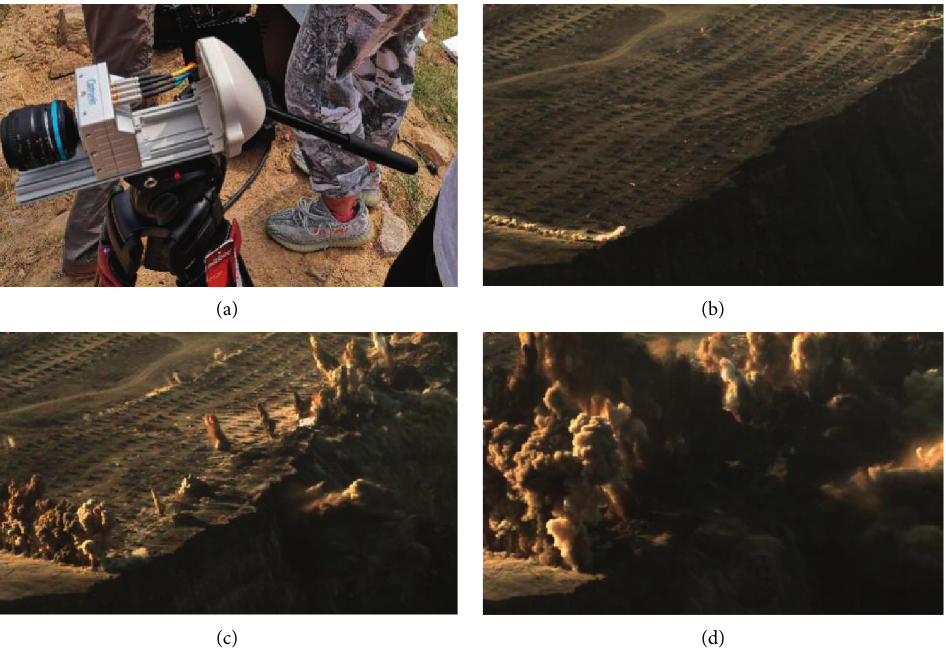
Figure 5: High-speed photography of the blasting process: (a) high-speed camera, (b) presplit hole initiation, (c) detonation of the main blast hole, and (d) a large amount of smoke and